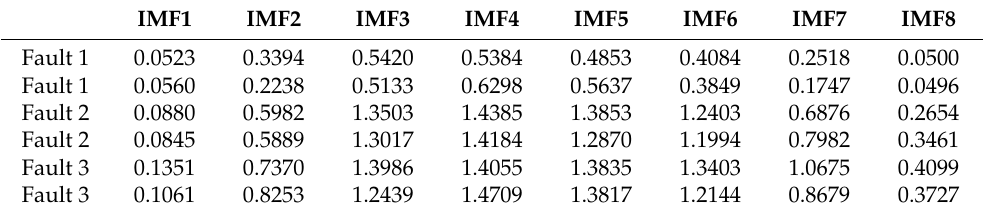
Table 3. The distribution of sample entropy corresponding to the IMF under each fault state.